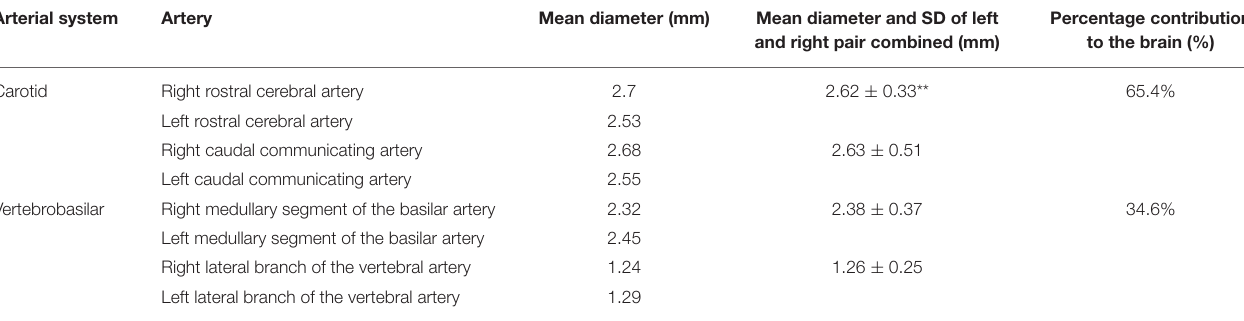
FIGURE 3 | A dorsal photograph showing the measurement sites of the afferent arterial supply to the ventral aspect of the dromedary brain. Here; 1, rostral cerebral artery; 2, caudal communicating artery; 3, basilar artery; 4, right and left medullary segments of basilar artery. The measurement of a and b indicate the contribution of the carotid arterial system to the brain while c indicates the contribution of the vertebrobasilar system to the brain. Sequential diameter measurements of the basilar artery were taken at d, e and f.